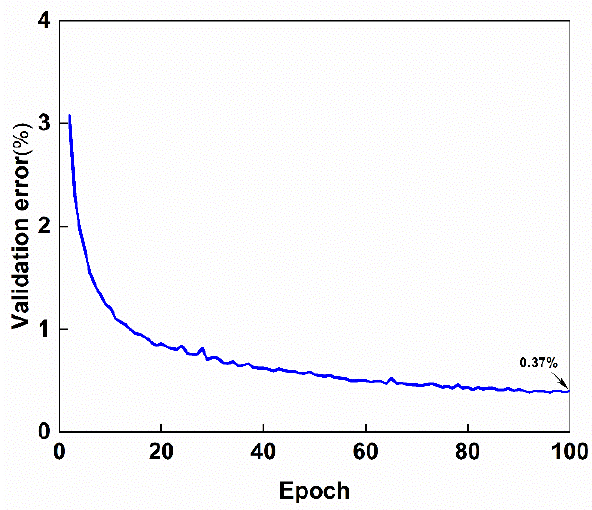
Figure 10. Convergence graph of ANN training [33].